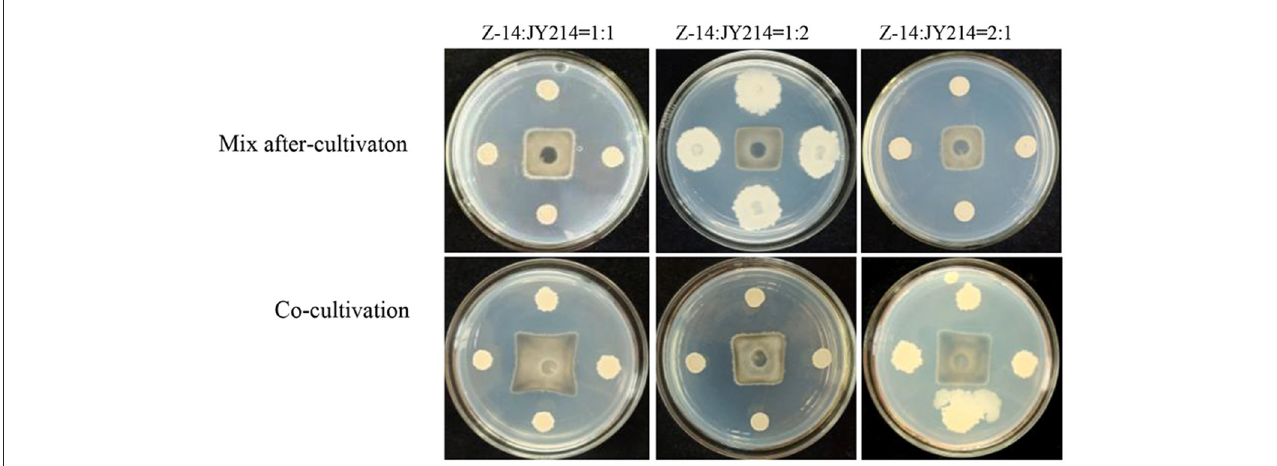
FIGURE6 Inhibition test of different mixing method and ratios of Z-14 and JY214 against Ggt . Z-14 and JY214 were mixed in ratios of 1:1, 1:2, and 2:1 respectively to test the inhibition effect of the mixture on Ggt .